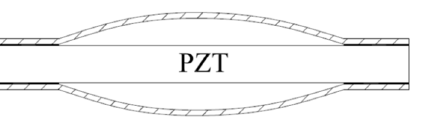
Figure 24. Structure diagram of cymbal with bolt ( left ) and multilayer cavity ( right ).